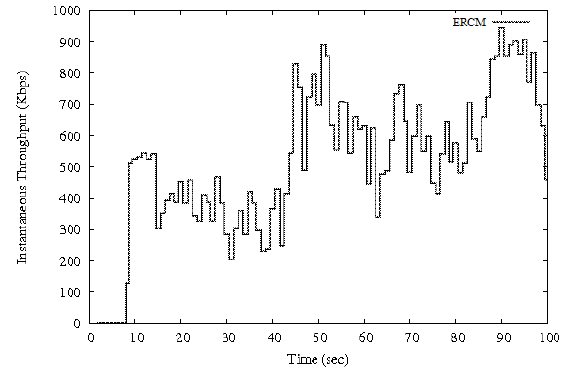
Fig. 3. Instantaneous throughput of ERCM